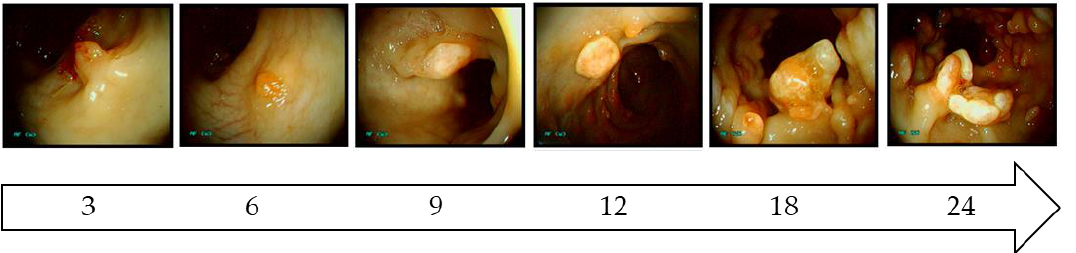
Figure 2. Phenotype of adenomatous polyposis coli (APC) 1311 pigs. Polyp progression during the first 24 months.